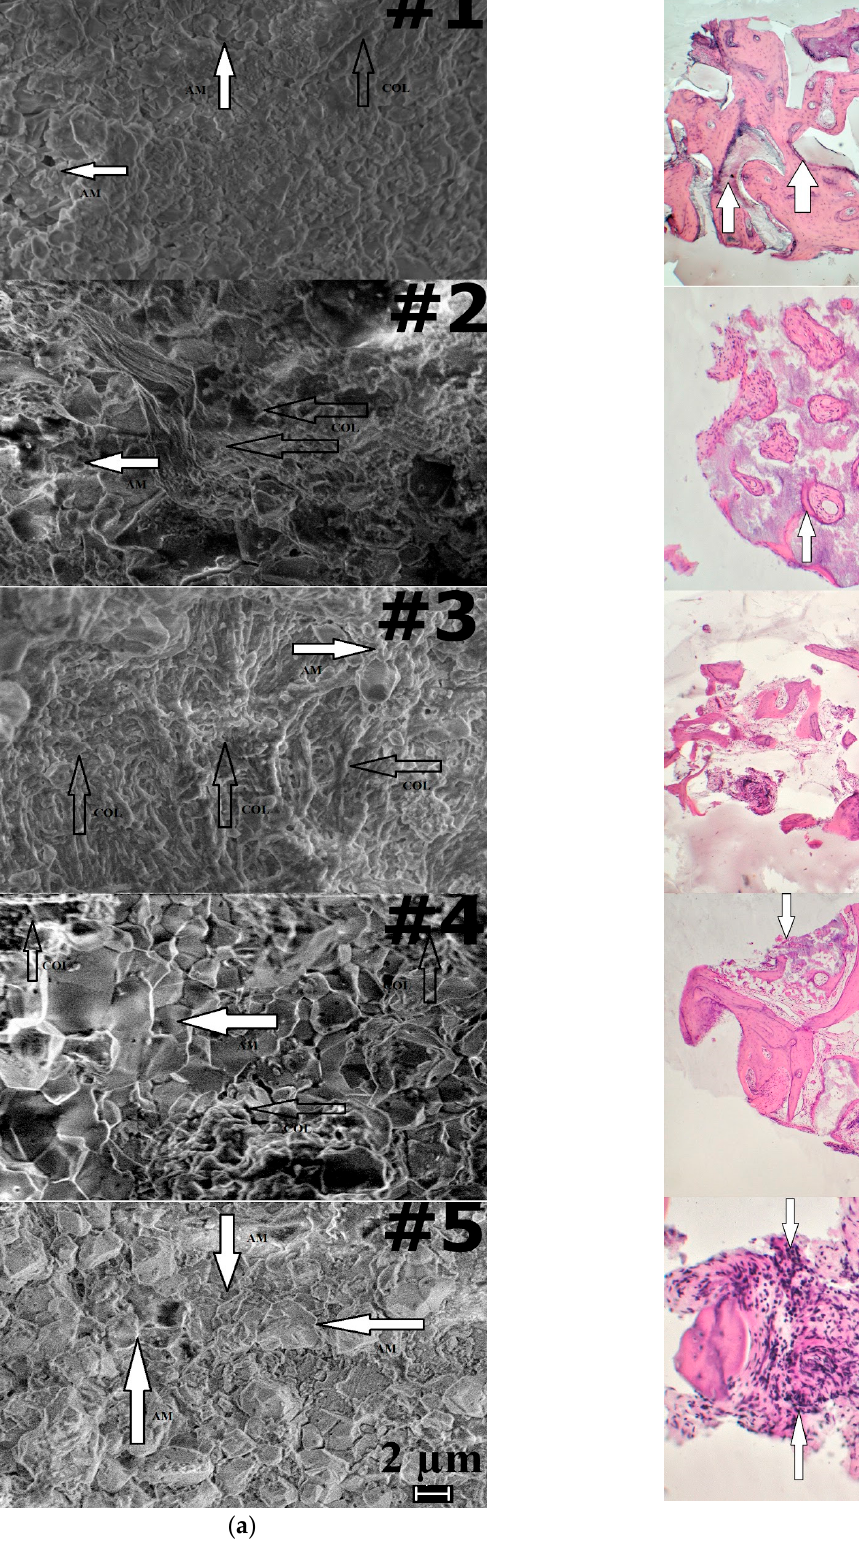
Figure 3. ( a ) SEM micrographs of bone samples, magnification 10,000X. Legend: COL—collagen (white arrows), AM—bone augmentation material (black arrows); ( b ) Histology, morphological changes reflecting the condition of the biological augmentation process using HAP (Cerabone) as bone substitute. Changes are indicated by arrows for the specific areas.